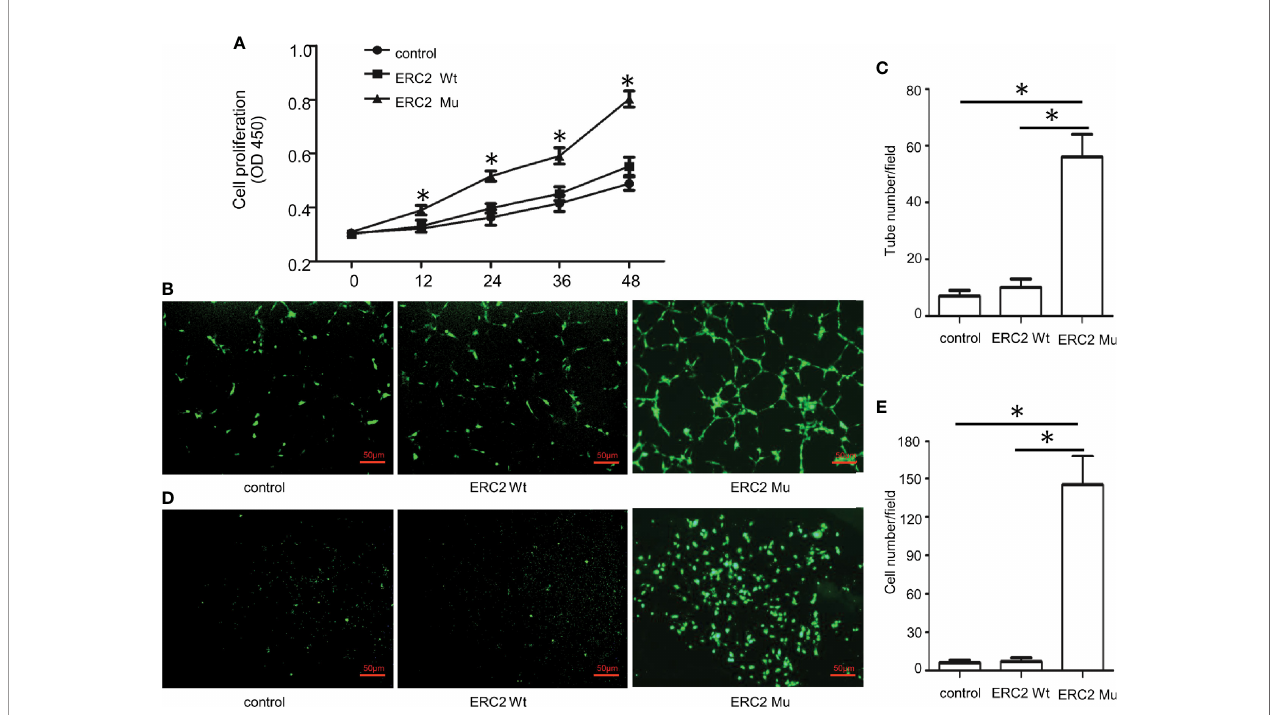
FIGURE 7 | The effects of the ERC2 L309I mutation on endothelial angiogenesis. HUVECs were transfected with ERC2 wt and ERC2 mu (L309I) lentiviruses and then subjected to angiogenesis analysis. (A) Proliferation results by analysis of WST-8 fl uorescence (n = 3). (B) Representative images for analysis of tubular formation. (C) Quantitative results for capillary-like tube formation (n = 3). (D) Representative images for transwell migration assays. (E) A bar graph displaying the data from 3 independent transwell migration assays. (*P<0.05).